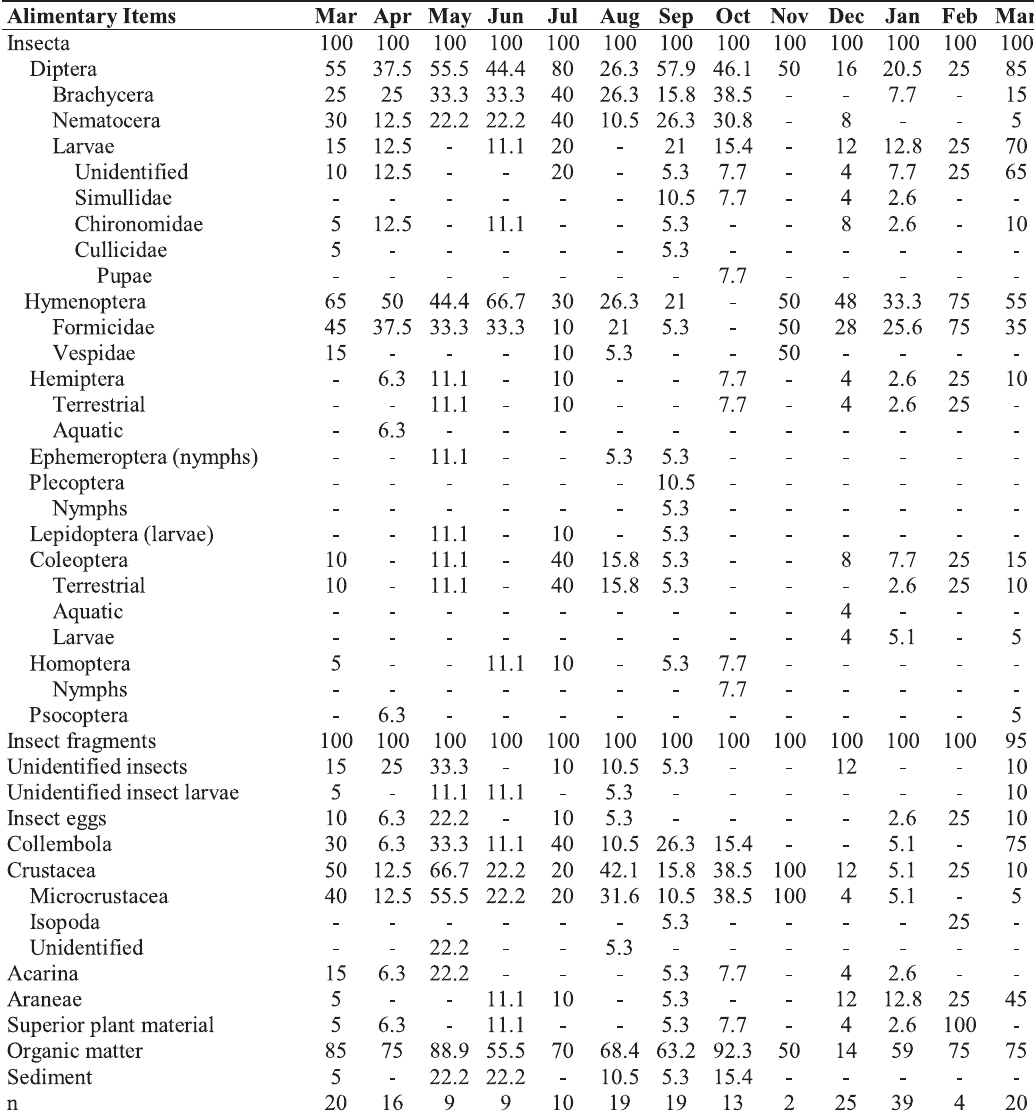
Table 1. Frequency of occurrence of the dietary items found in the stomachs of Mimagoniates rheocharis in Station 1 (n = number of examined